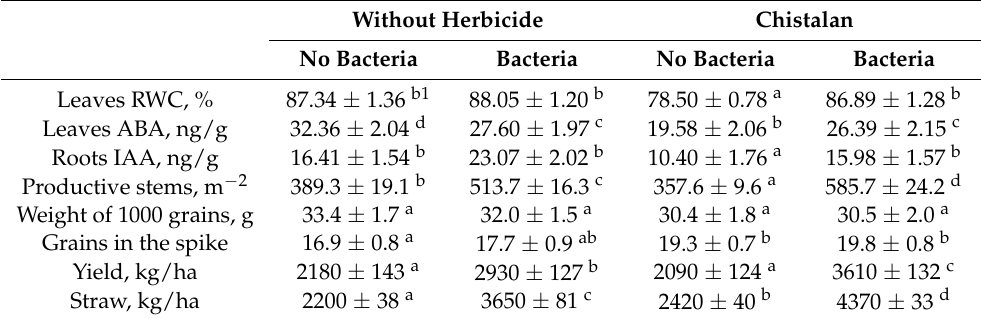
Table 1. Relative water content, amount of phytohormones in shoots and roots, and wheat yield parameters in field plots differing in the use of the herbicide Chistalan and the bacterium Pseudomonas protegens